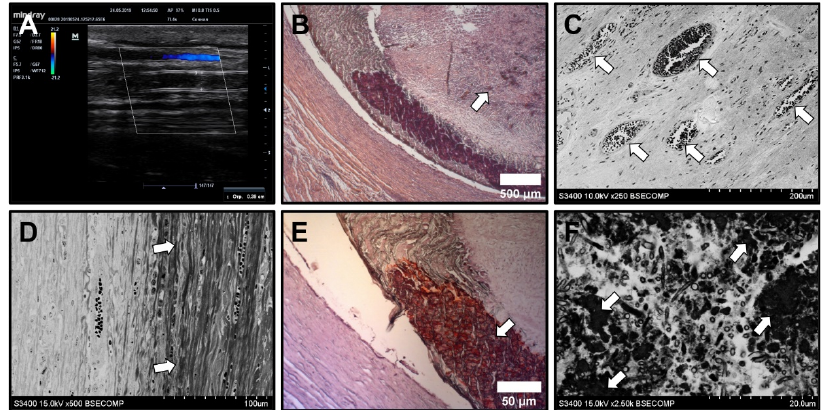
Figure 8. Histological and ultrastructural examination of ePTFE vascular prostheses. ( A ) Detection of thrombosis by Doppler ultrasound examination; ( B ) Thrombotic occlusion (white arrow), haema- toxylin and eosin staining, × 50 magnification; ( C ) Recanalised thrombus (recanalising microvessels are indicated by white arrows), backscattered scanning electron microscopy, × 250 magnification; ( D ) Connective tissue capsule (white arrows), backscattered scanning electron microscopy, × 500 magnifi- cation. ( E ) Calcification (white arrow) within the connective tissue capsule, alizarin red S staining, × 100 magnification; ( F ) Microcalcifications within the thrombus (white arrows), backscattered scan- ning electron microscopy, × 250 magnification. Representative